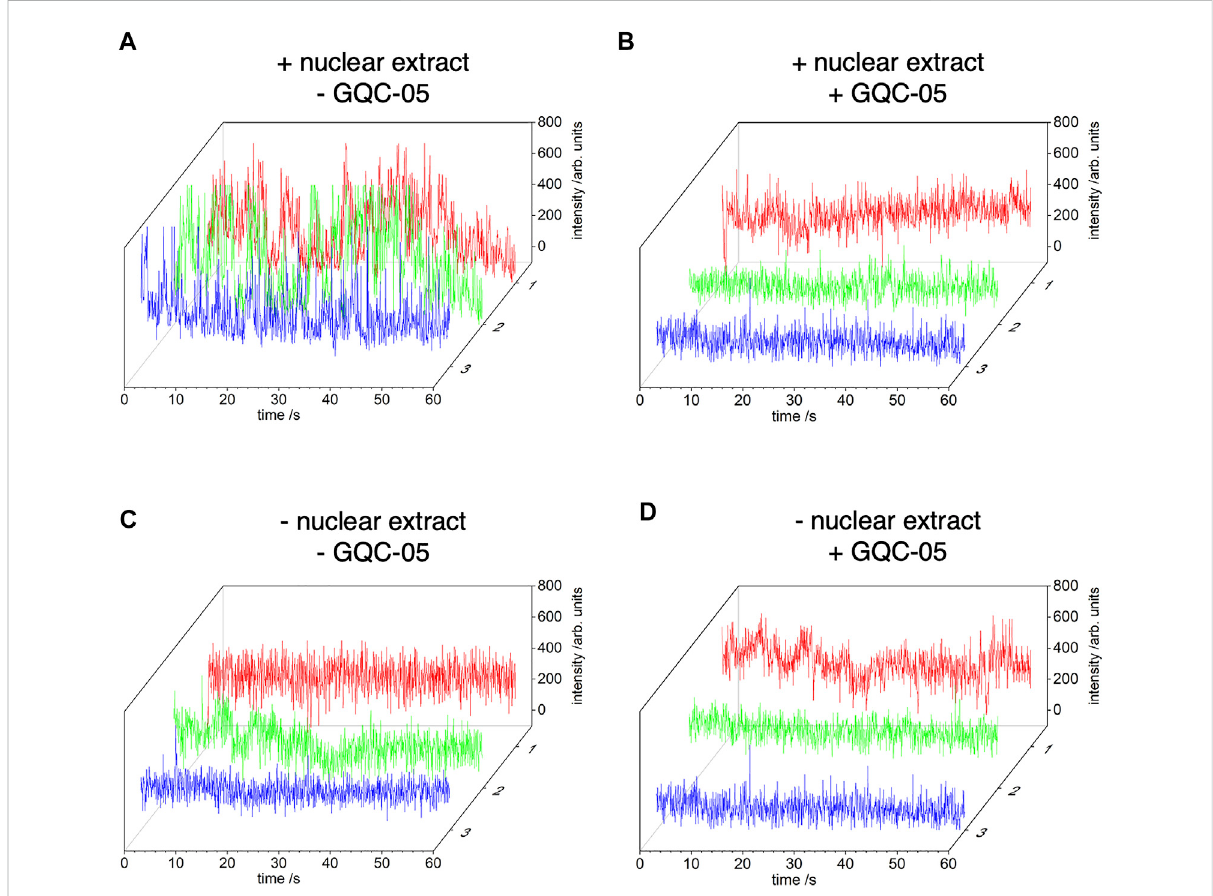
FIGURE 8 Time-resolved single-molecule (FRET) between AlexaFluor546 and DABCYL. Q2 RNA was labelled, after the fi rst G-tract, with AlexaFluor546 dye and, after the third G-tract, with DABCYL. A biotin-tag was incorporated at the 5 ′ end of Q2 RNA and the oligonucleotide was tetheredto thesurfaceofcover glasses viabiotin-avidin linkages. Thephotoncountfrom AlexaFluor546 isshown forthree separate copiesofsingle molecules of Q2 RNA obtained from images recorded with a 50 ms integration time (approx. 20 frame per second). Experiments were conducted in 20% nuclear extract (the exact buffer composition is described in the method section 2.9), in the absence (A) or presence (B) of GQC- 05 respectively. Control experiments were conducted in the same conditions but in the absence of nuclear extract (C) and (D)